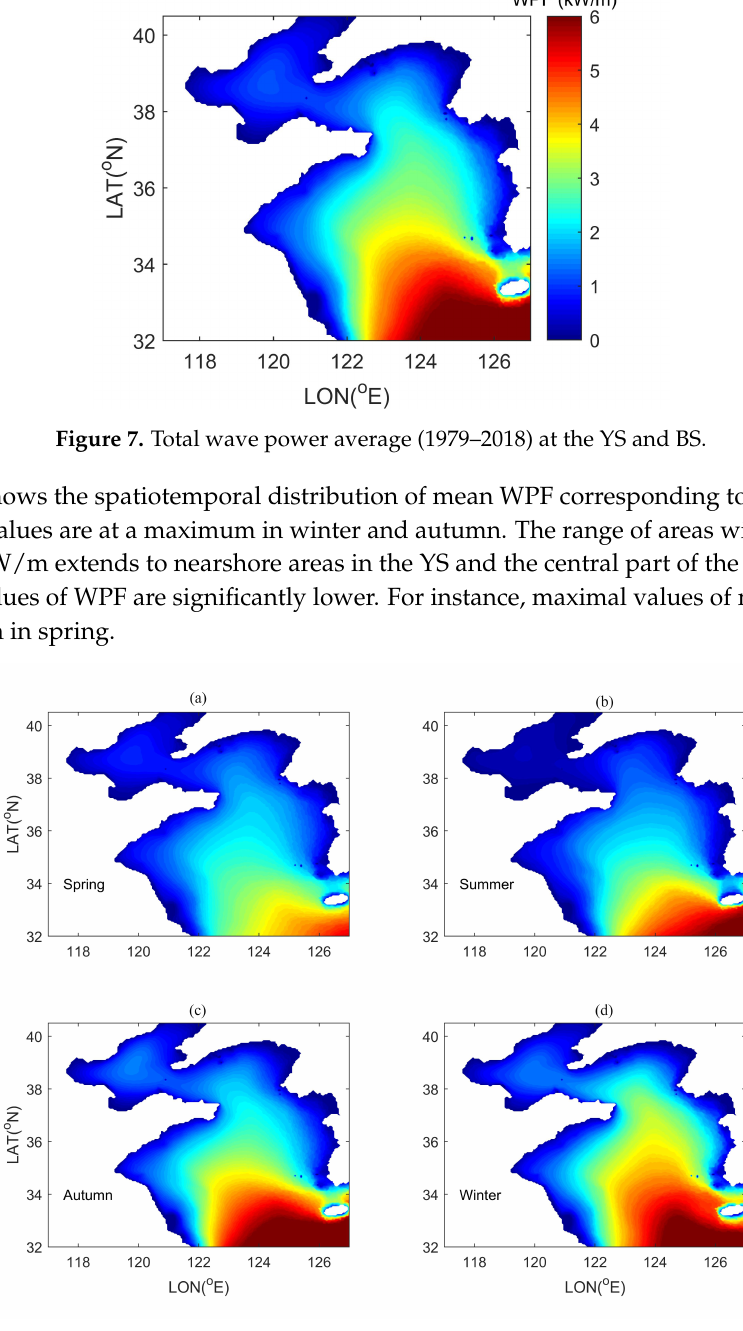
Figure 8. Seasonal wave power average for the time period 1979–2018 in the YS and BS (( a ) Spring; ( b ) Summer; ( c ) Autumn; ( d )